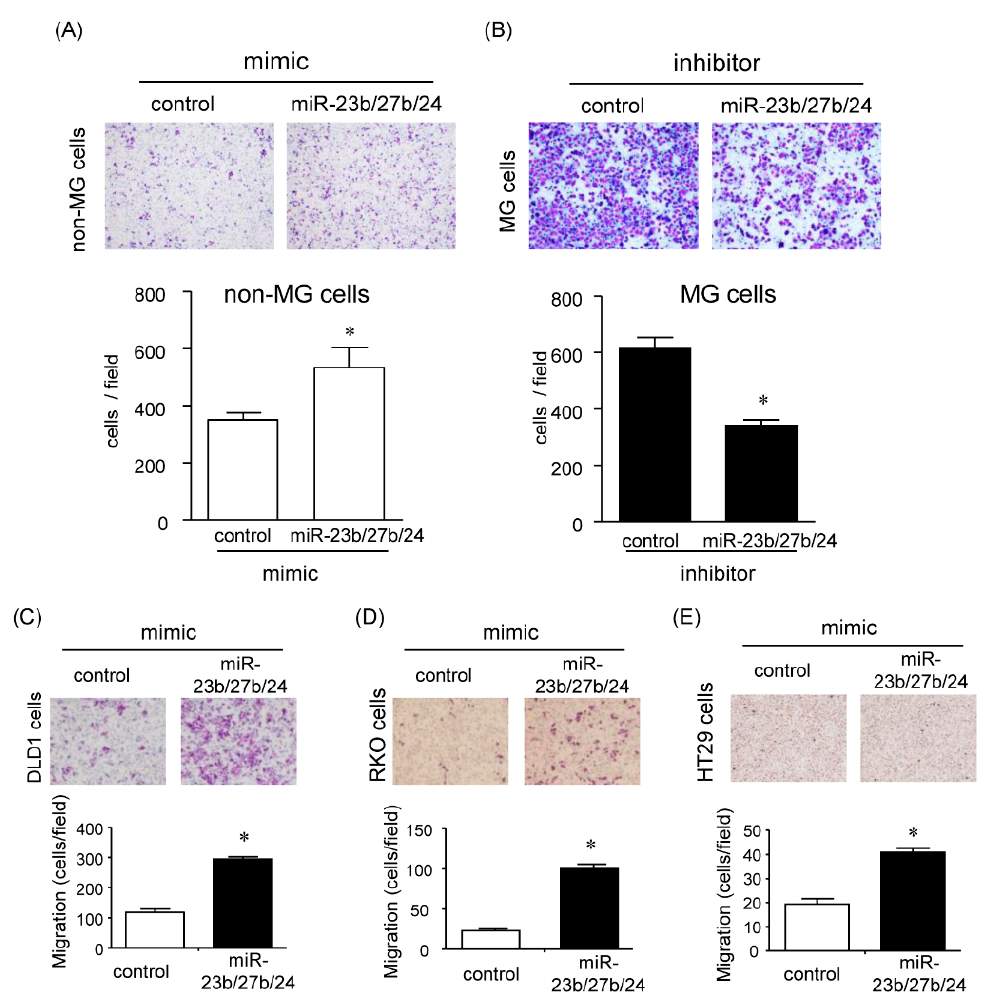
Figure 4. E ff ects of miR-23b / 27b / 24 on cell migration. ( A , B ) Transwell migration (n = 4) assays were performed in mixed mimic or inhibitor of microRNAs ( miR-23b , miR-27b and miR-24 )-transfected HCT116 cells. Upper panels show representative images of Di ff -Quick staining in four experiments of transwell migration assays, and a lower graph shows quantification of cell migration expressed by cell counting. ( C – E ) Transwell migration assays were performed in mixed mimic of microRNAs ( miR-23b , miR-27b , and miR-24 )-transfected DLD1, RKO, or HT29 cells. Upper panels and lower graphs are the same as in (aA). Values represent mean ± SD. n = 4. * Statistically significant di ff erence versus control (unpaired Student’s t -test, p < 0.05).